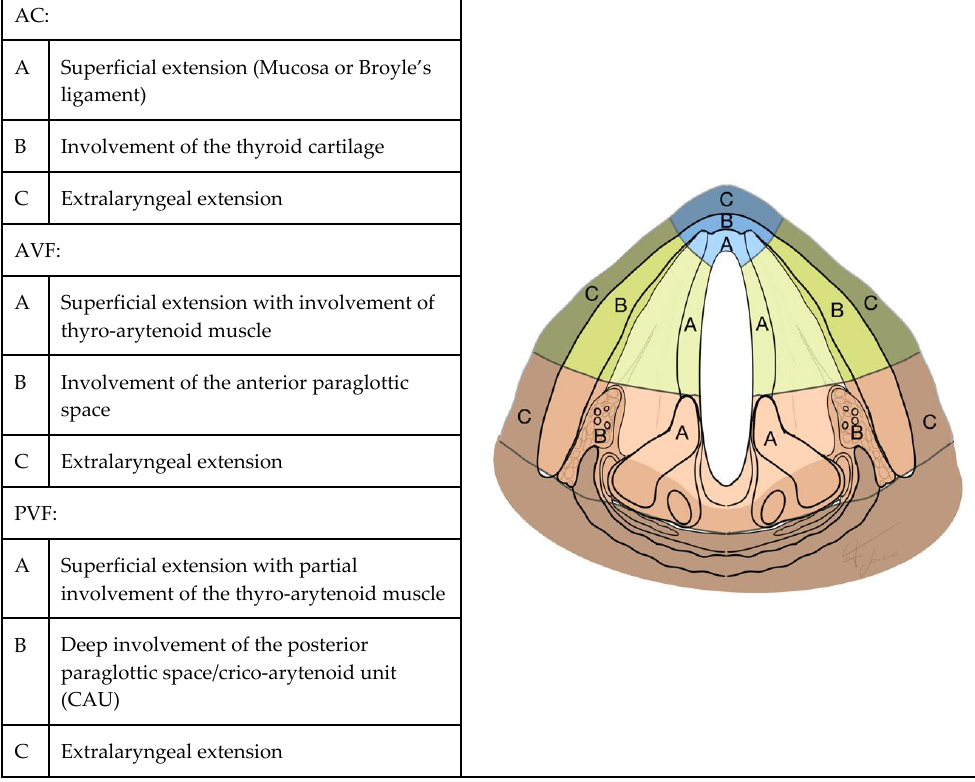
Figure 6. Glottic map: subsites and layers of depth. AC: anterior commissure, AVF: anterior vocal fold and PVF: posterior vocal fold.